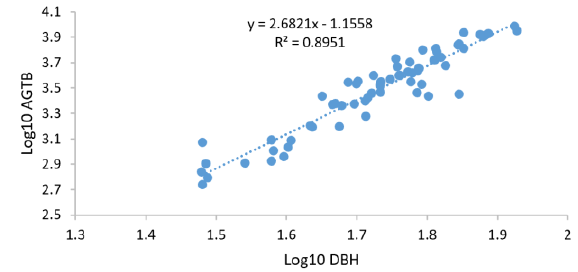
Figure 12. Relationship between DBH and AGTB